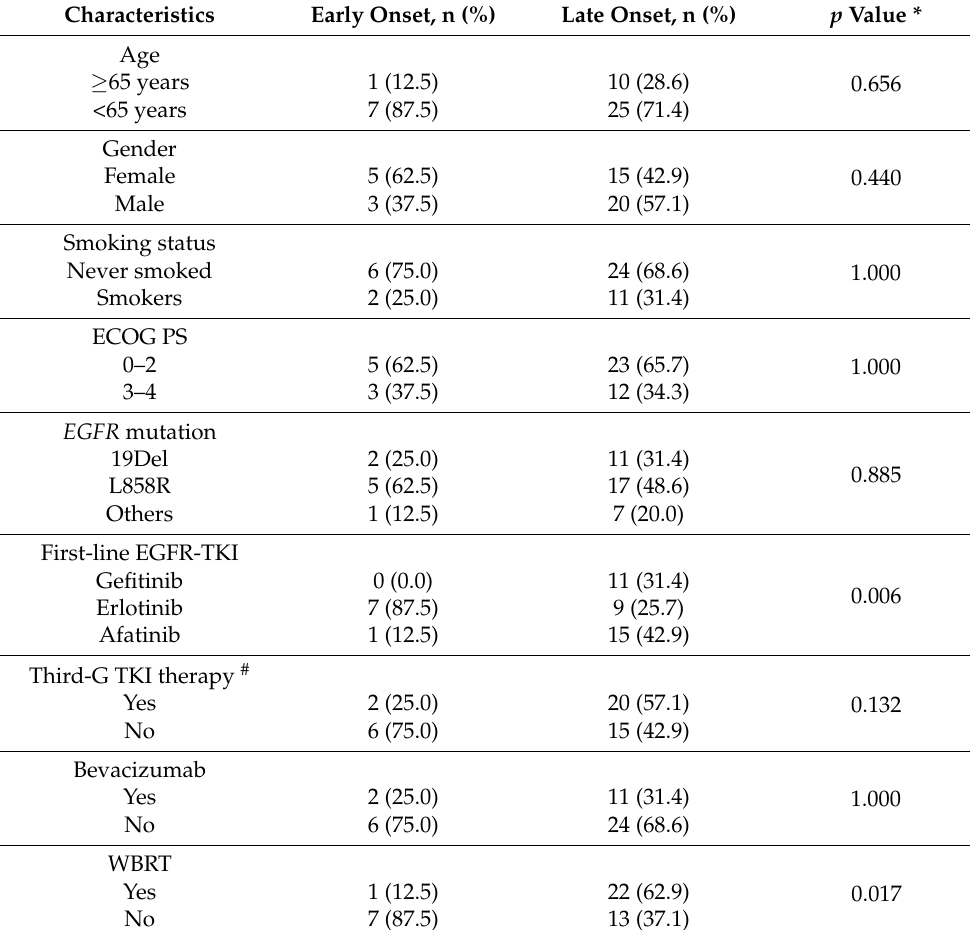
Table 2. Univariate analysis of patient characteristics, treatment patterns, and the onset of lep- tomeningeal